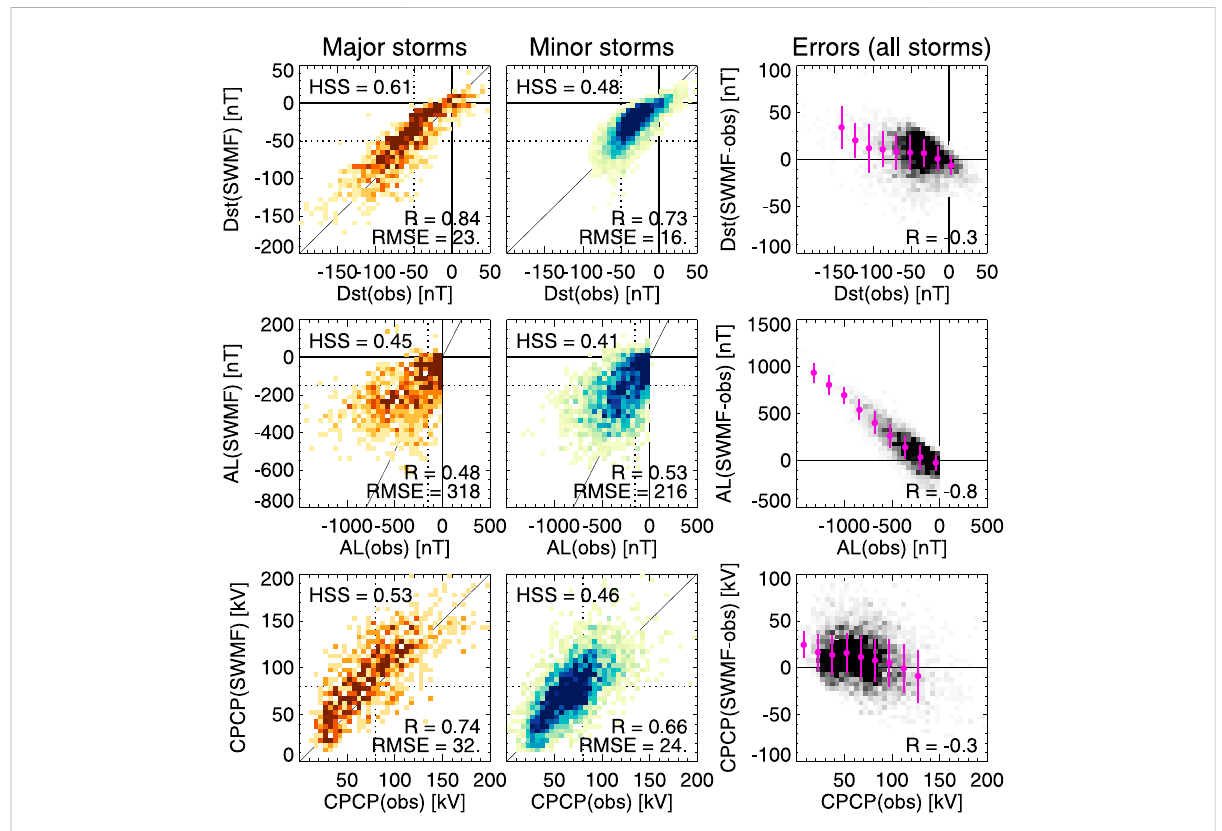
FIGURE 6 Heat map plots showing hourly values of (Top row) Dst; (Middle row) AL; and (Bottom row) the CPCP observed vs. simulated values, for (Right column) major storms and(Center column) minor storms. The unity line is shown in thin solid line, the dotted linesshow the threshold values used in the Heidke Skill Score (HSS) calculation (see text).The heat maps indicate the share of points falling in each bin. (Right column) Errors(simulated – observed value) as function of the observed values. The magenta dotsshow bin averages, and the vertical thin lines indicate the standard deviation in